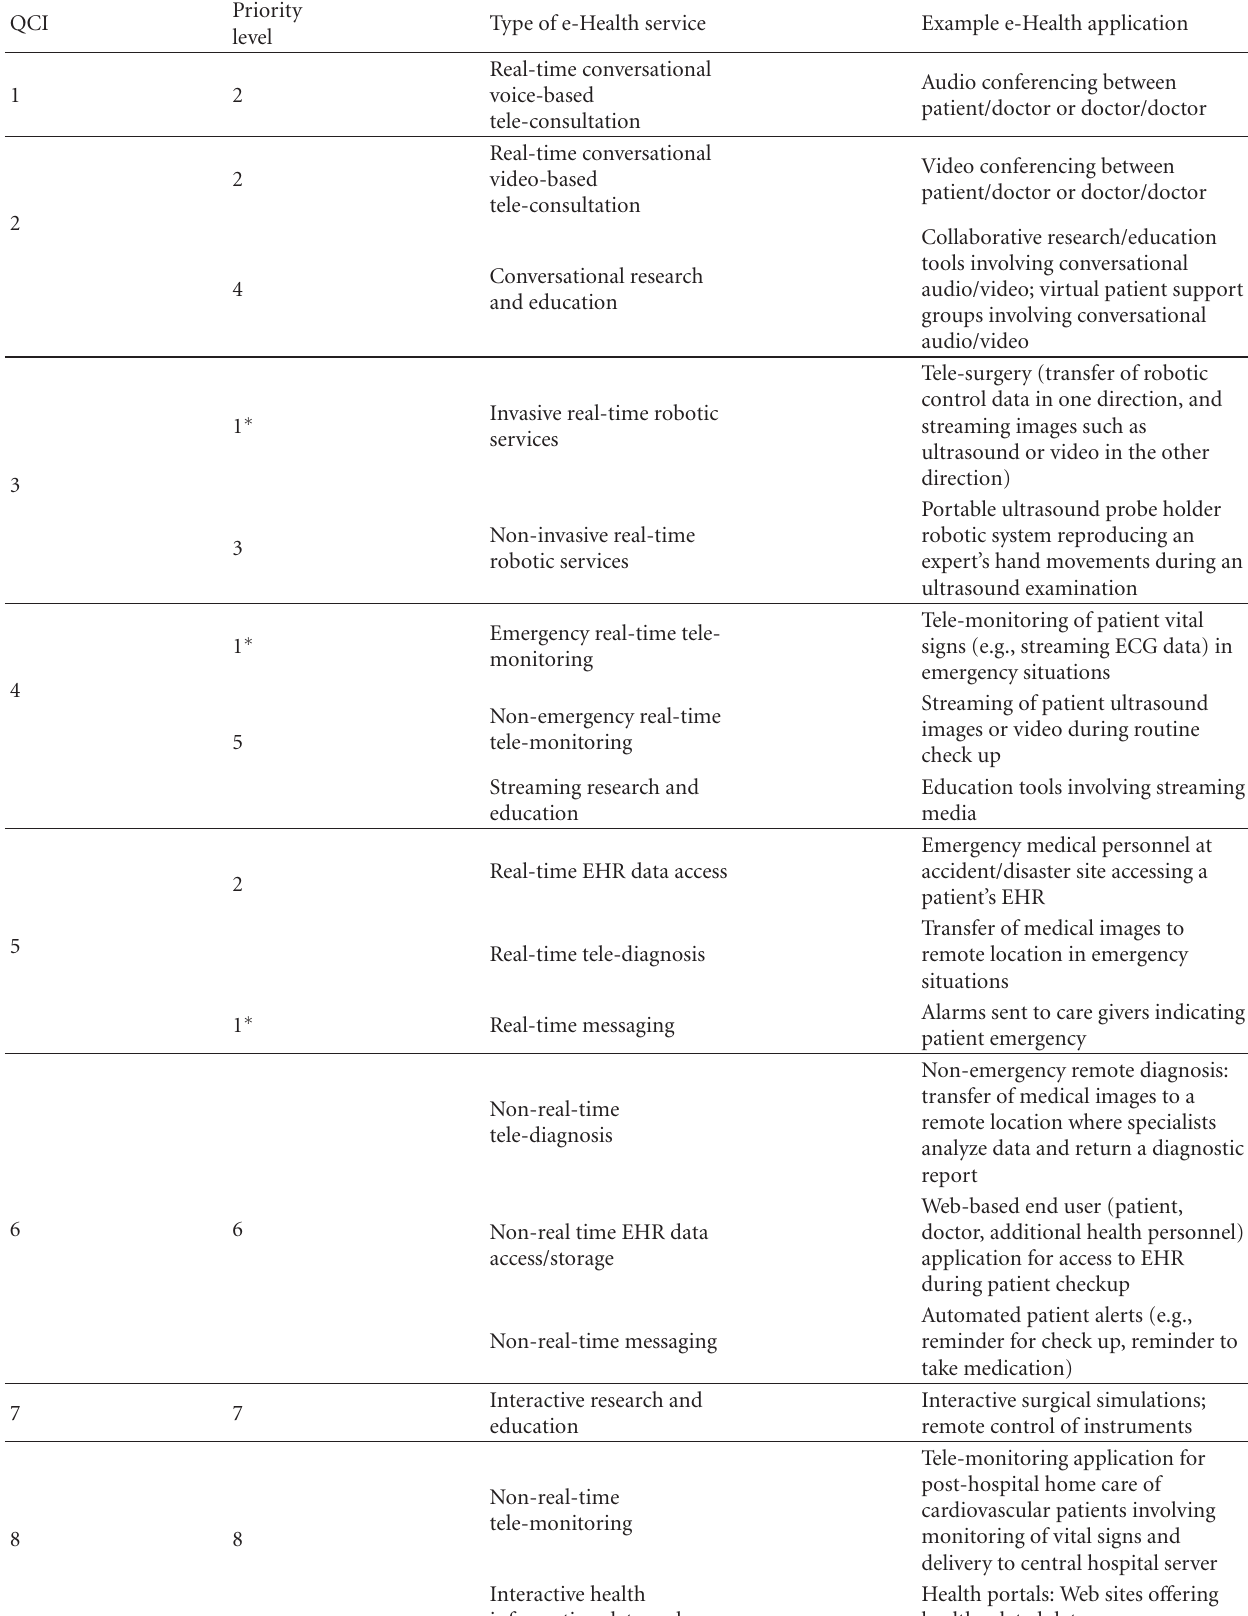
Table 7: Proposed mapping of e-Health service types to standardized